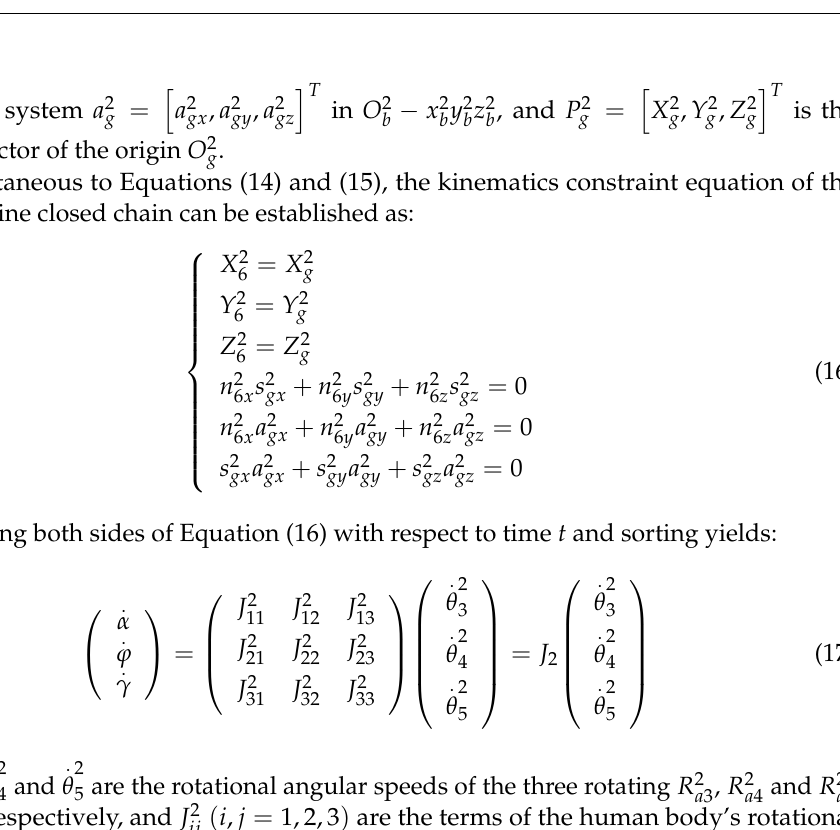
Table 2. Dimension parameter table of the 2 P a 1 P 3 R a and 5 R a 1 P man machine closed chain. Parameter Value/(mm) Parameter Value/(mm) Scapula belt length l sg 150 Distance l 1 from human sternum to rotation pair R 2 Distance l 1 from P 1 to P 2 200 Distance from R 2 Distance l 2 from P 2 to P 3 200 Length of parallel four-bar mechanism 150 Distance l 3 from P 3 to R 4 200 Distance l 2 from R 2